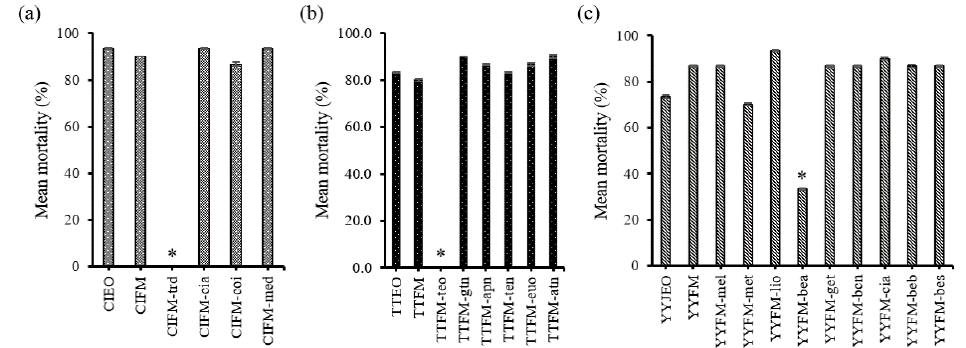
Figure 4. Compound elimination assay via fumigation assay: ( a ) cinnamon oil at LC 95 of 238.6 mg / L air; ( b ) tea tree oil at LC 95 of 114.5 mg / L air; ( c ) ylang ylang oil at LC 95 of 142.0 mg / L air against S. zeamais adults. Asterisks denote significant di ff erences at p = 0.05. (apn: ( + )- α -pinene, atn: α -terpinene, bcn: β -caryophyllene, bea: benzyl acetate, beb: benzyl benzoate, bes: benzyl salicylate, cia: cinnamyl acetate, coi: coumarin, euo: eucalyptol, get: geranyl acetate, gtn: γ -terpinene, lio: linalool, med: ( E )-4- methoxycinnamaldehyde, mel: 4-methylanisole, met: methyl benzoate, ten: terpinolene, teo: (–)- terpinen-4-ol, trd: trans -cinnamaldehyde).